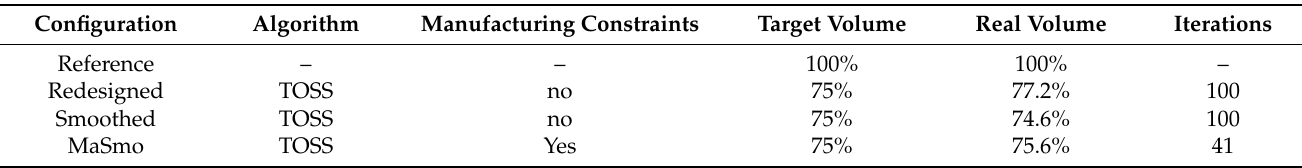
Table 2. Overview of the TO settings of all configurations. Since reference is the initial design space, no TO is performed for this configuration. All volumes are referenced on the volume of the reference configuration.